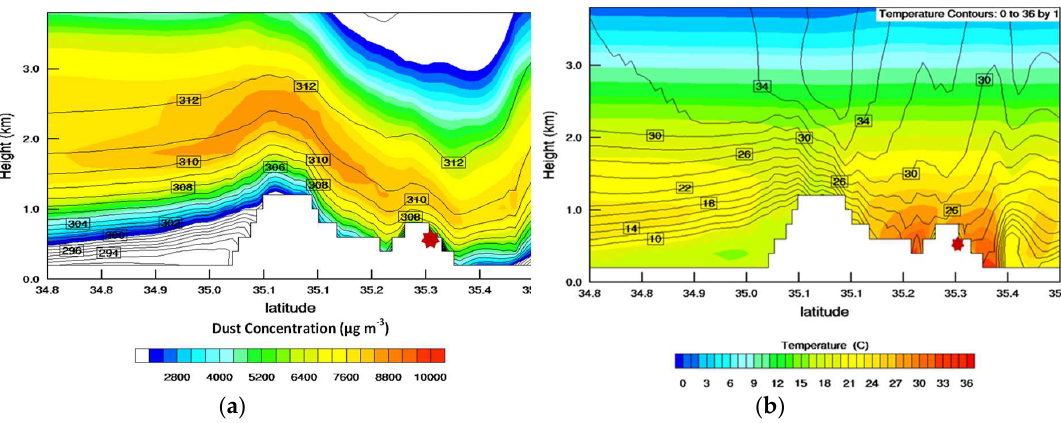
Figure 9. Model cross-section over Finokalia from the inner 1 × 1 km grid at 1600 UTC, 22 March 2018: ( a ) Dust concentration (color scale in μg m −3 ) and potential temperature (line contours) and ( b ) temperature (color scale in °C) and wind speed (line contours every 2 m s −1 ) at 1700 UTC, 22 March 2018. The red start roughly depicts the location of Finokalia station.